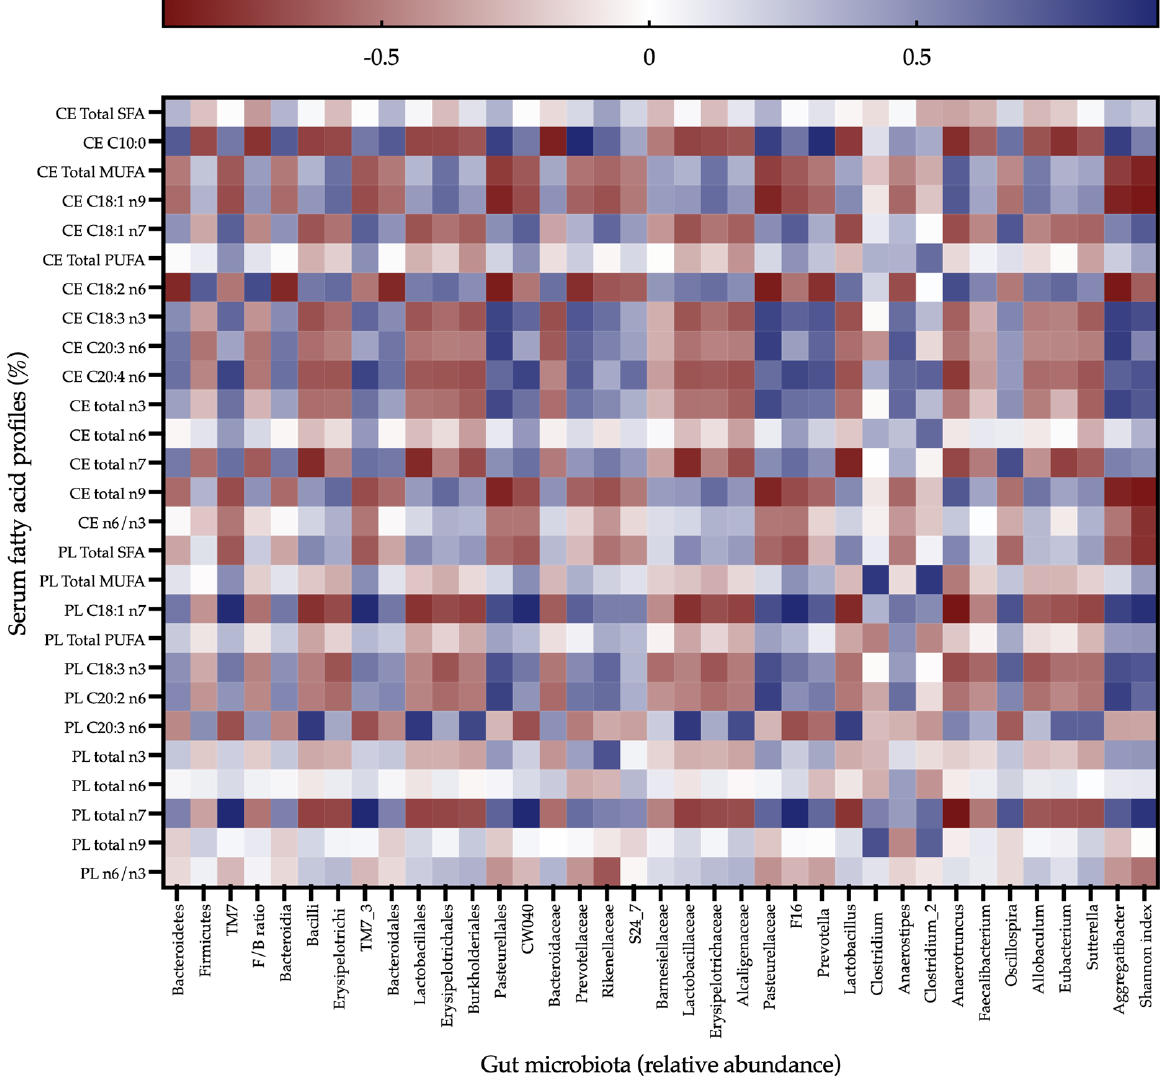
Figure 5. Correlation analysis between gut microbiome and serum metabolites assessed using Pearson’s correlation coefficient. Positive and negative correlation coefficients are colored blue and red, respectively. The intensity of the color represents the degree of correlation.